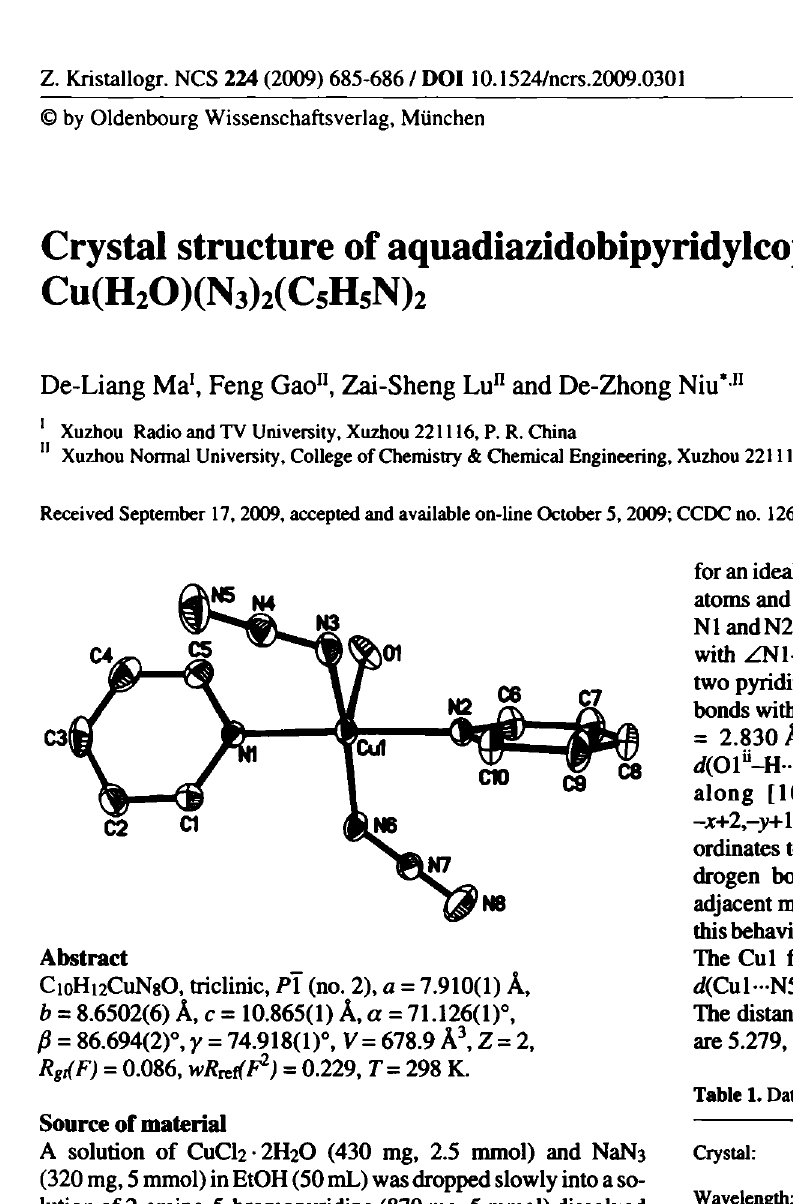
Table 2. Atomic coordinates and displacement parameters (in Â 2